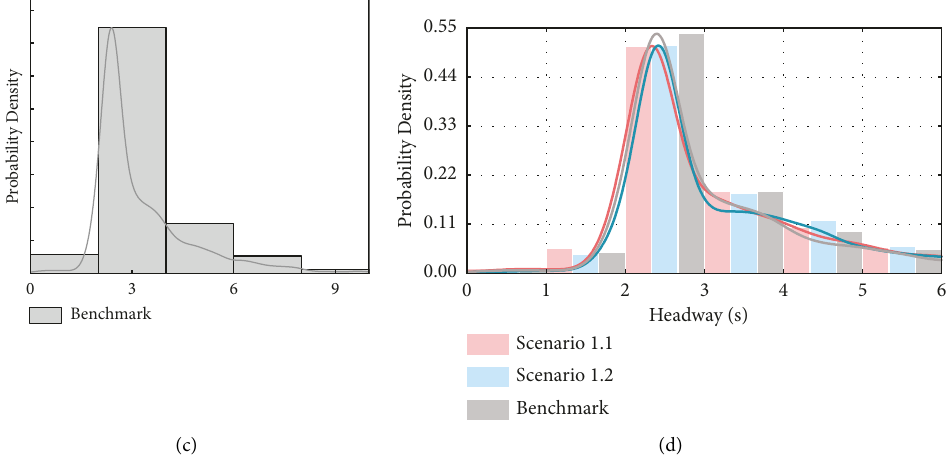
Figure 7: The results for the first simulation under the headway: (a) the probability density of the headway in scenario 1.1, (b) the probability density of the headway in scenario 1.2, (c) the probability density of the headway in the benchmark scenario, and (d) the comparison of the three scenarios under the